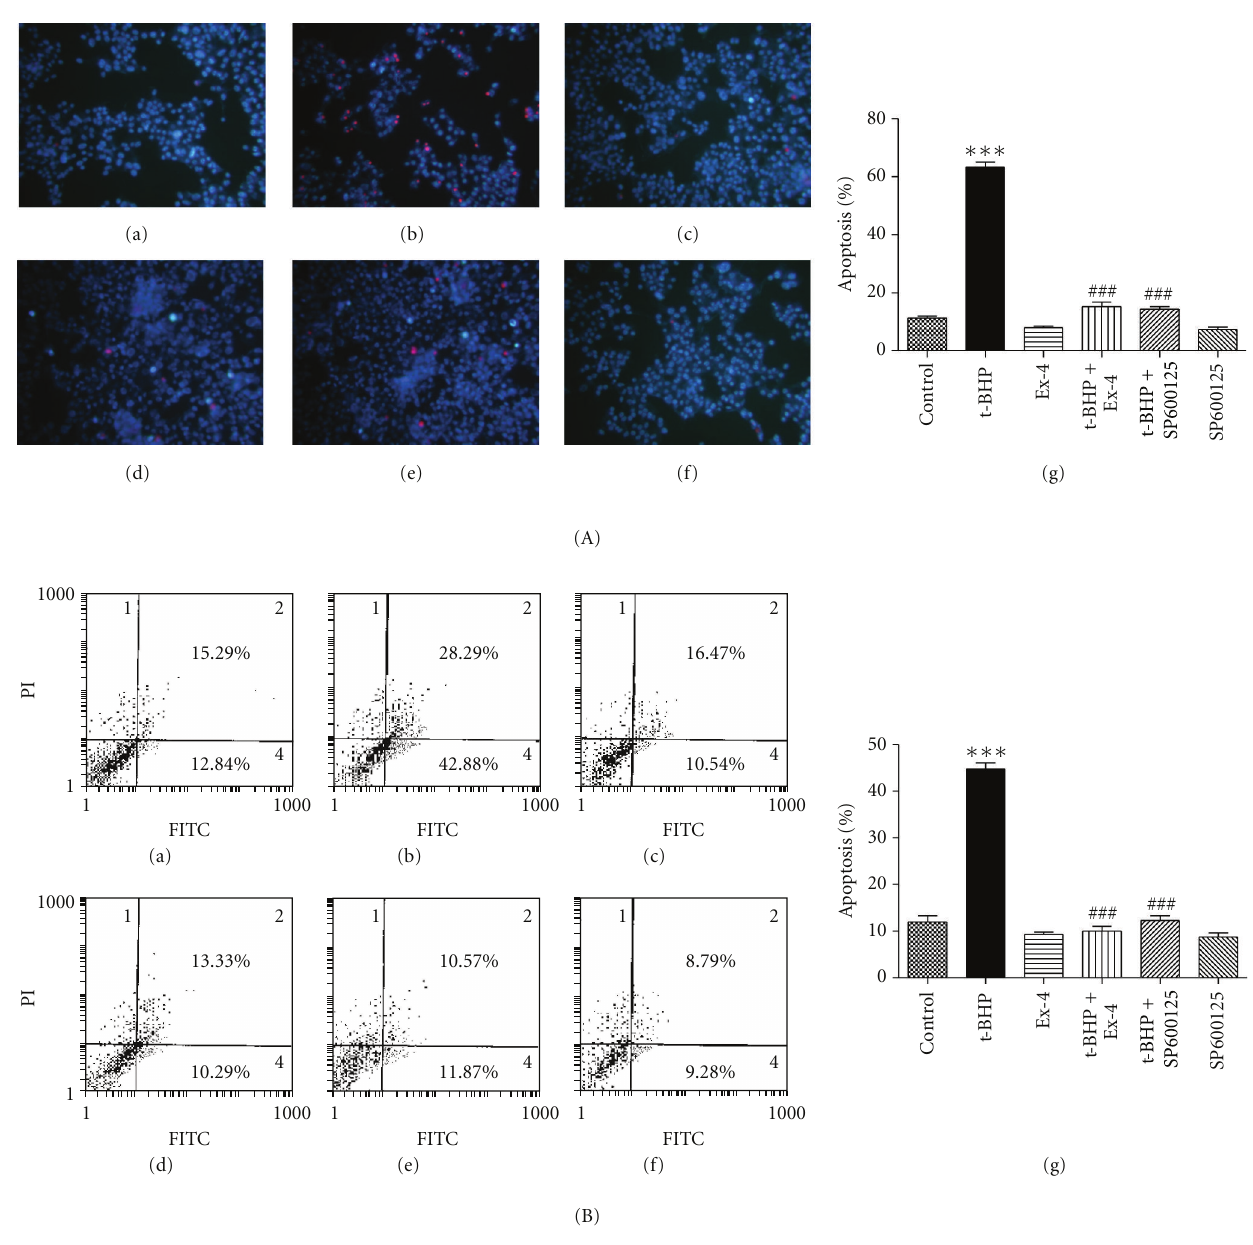
Figure 1: Exendin-4 inhibits t-BHP-induced β -cell apoptosis. MIN6 cells were preincubated with exendin-4 (100nM) or with SP600125 (10nM) for 18h and then exposed to t-BHP (25 μ M) for 1h. The rate of apoptosis was determined by Hoechst/PI staining (A) and flow cytometry (B). The cells containing bright blue particles (apoptosis-positive cells) were visualized under a light microscope (A). (a) Control; (b) t-BHP alone; (c) exendin-4 (Ex-4) alone; (d) Ex-4 + t-BHP; (e) SP600125 + t-BHP; (f) SP600125; (g) quantification of apoptotic cells. Values are expressed as the mean ± SD ( n = 3). ∗∗∗ P < 0 . 001 compared with the control group; ### P < 0 . 001 versus t-BHP alone.